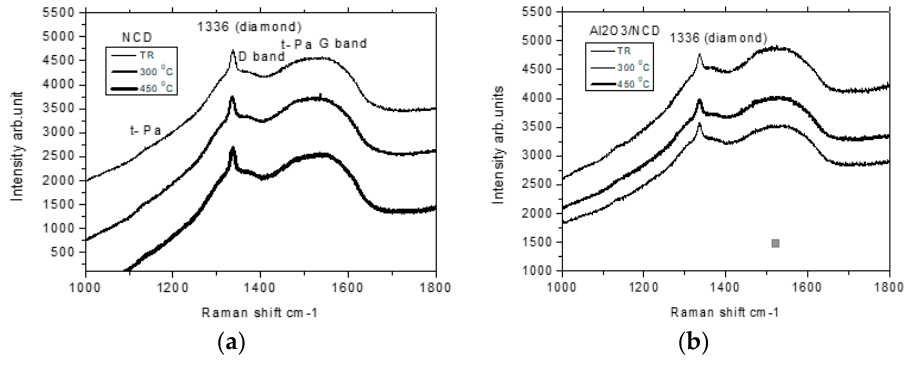
Figure 10. Raman spectra taken on the ( a ) NCD and ( b ) Al 2 O 3 /NCD films.